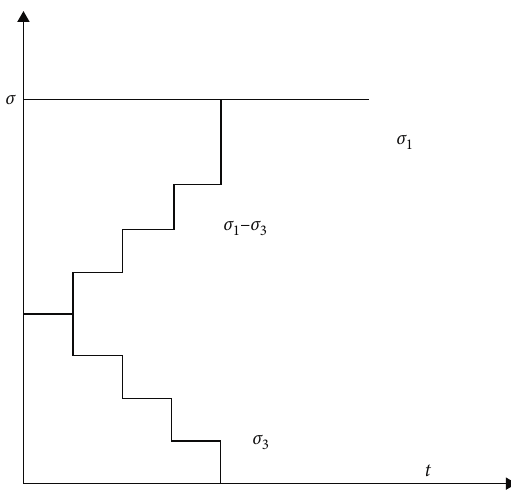
Figure 1: Unloading path